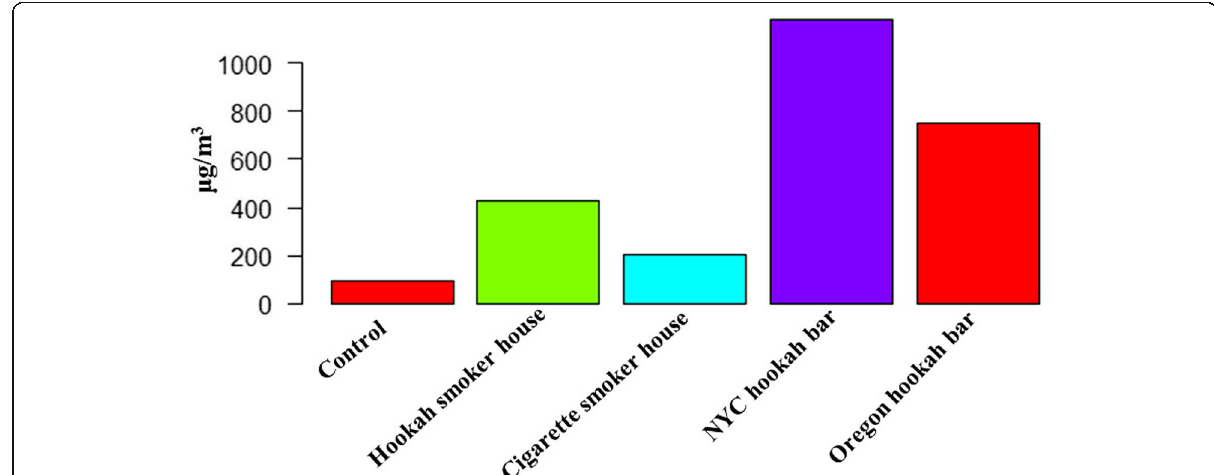
Fig. 5 Comparison between PM2.5 levels in houses of hookah users, cigarette users, and bars in two states. NYC hookah bars ( n =8). Oregon hookah bars ( n =10) [94, 96,